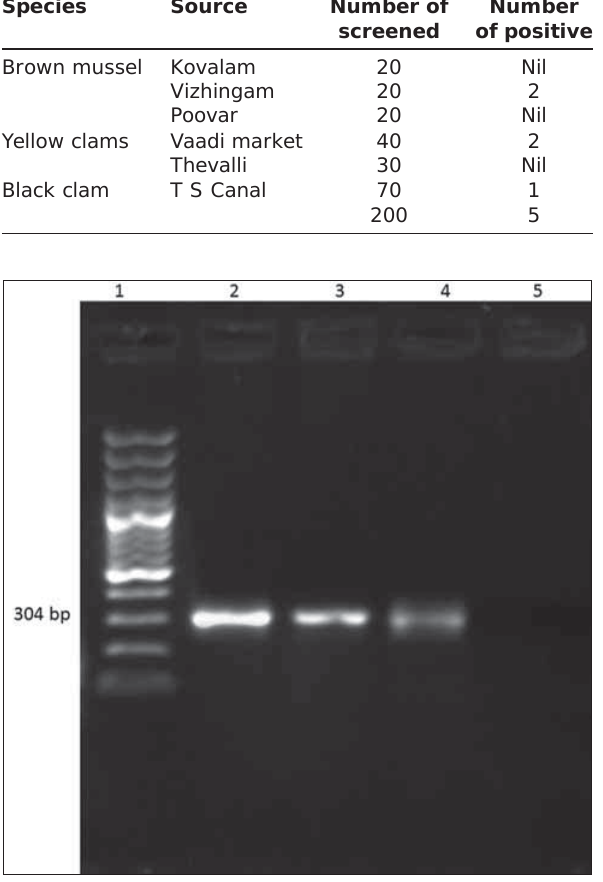
Figure-1: Shellfish samples positive for rotavirus . Lane 1 : 100 bp ladder . Lane 2 : Positive control. Lane 3 -4 : Positive shellfish samples. Lane 5 : Negative